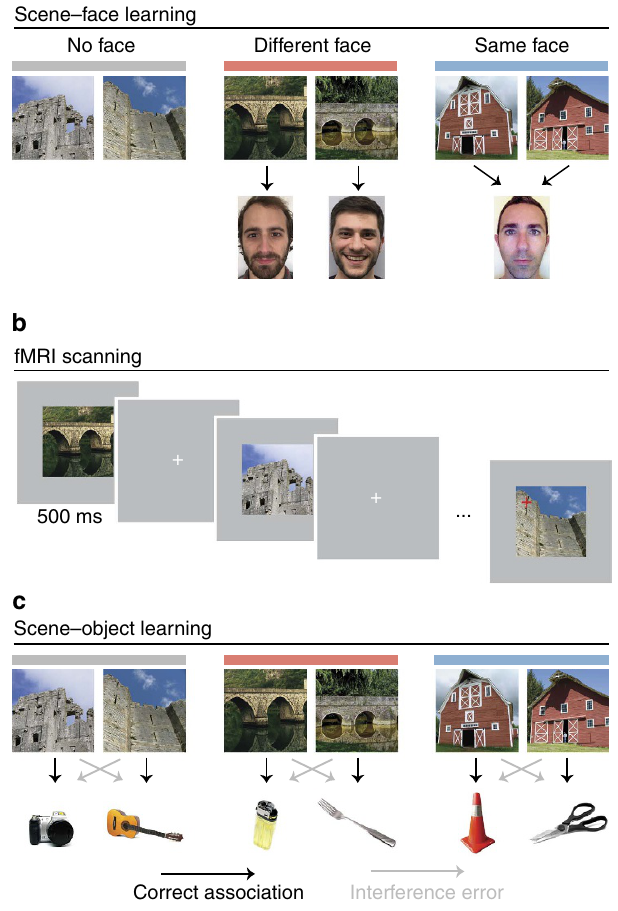
Figure 1 | Experimental design. ( a ) On day 1, subjects learned scene–face associations that were constructed using pairs of similar scenes (pairmates). Pairmates were associated with: no image at all (No Face condition), different faces (Different Face condition), or a common face (Same Face condition). Note that pairmates are shown side-by-side to illustrate the design, but subjects never saw any of the scene pairmates simultaneously. ( b ) During fMRI scanning on day 2, subjects viewed the scenes while performing an orthogonal visual target detection task. ( c ) After scanning, subjects learned scene–object associations where each scene was paired with a unique object. Memory for these associations was probed using a forced choice associative memory test. Interference errors occurred when subjects selected an object that had been paired with the scene’s pairmate (indicated by grey arrows). See also Supplementary Fig. 1 and Methods